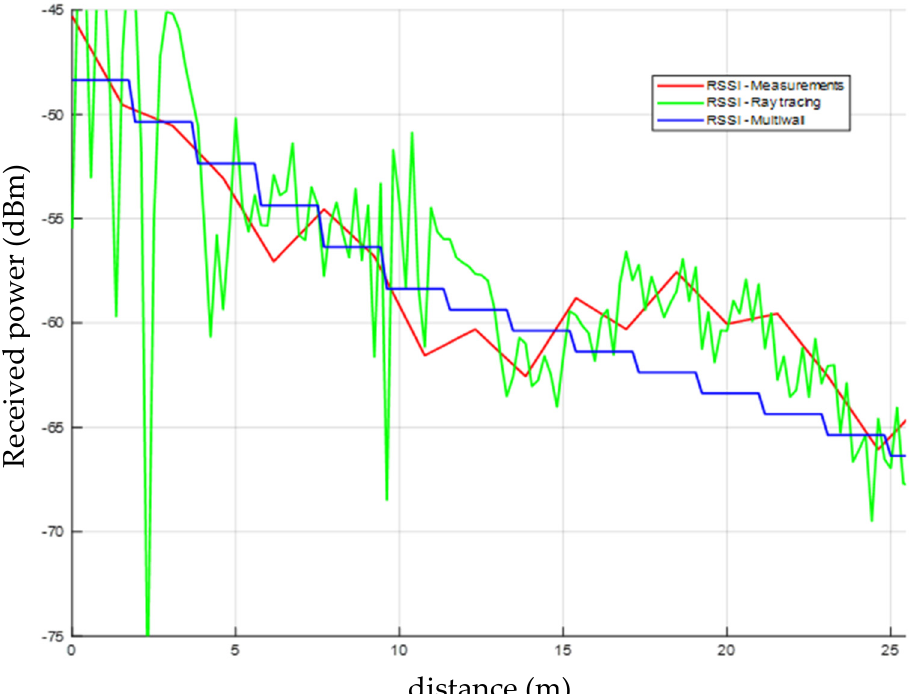
Figure 15. Readings of the measured RSSI signal strength (red) along the transition path of the mobile terminal with power values read from the reference map for the same route generated by computer simulations, using ray tracing (green) and multiwall (blue) models.